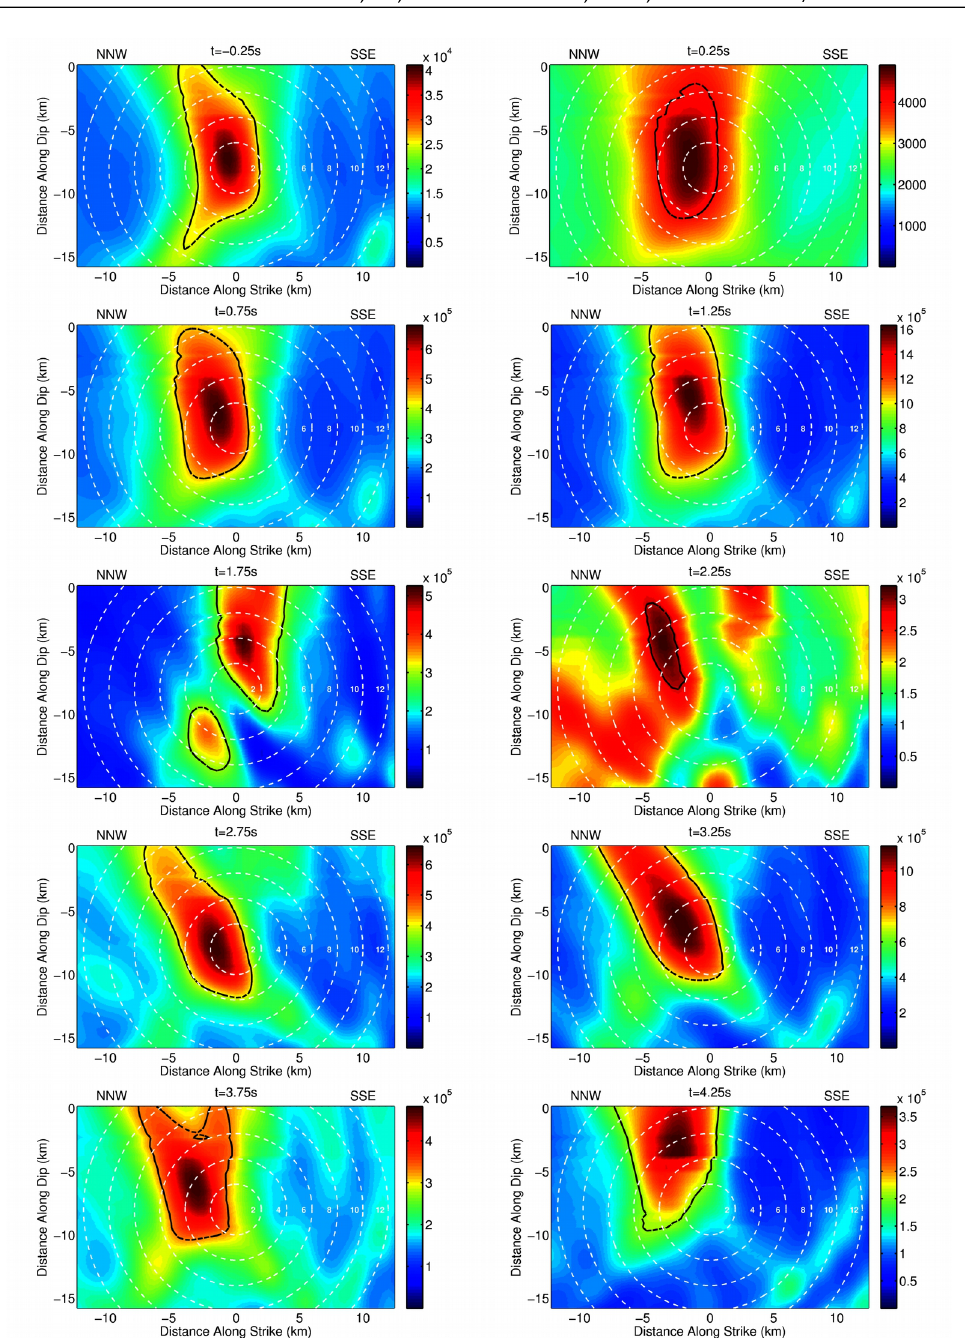
Figure 5 – Time dependent images of beam power over the model fault plane at subsequent time frames spaced by 0.5s. White, dashed circles are isolines of equal distance from the hypocenter